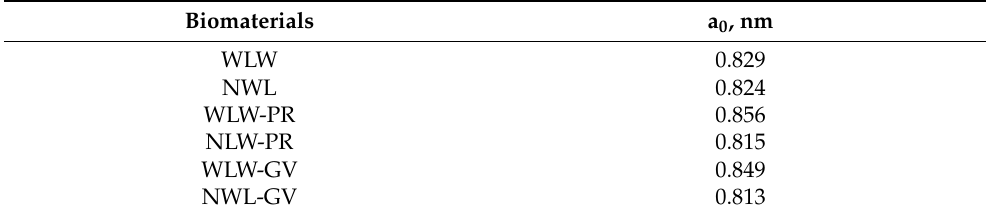
Table 12. Network parameters of the different biomaterials before and after the adsorption process.